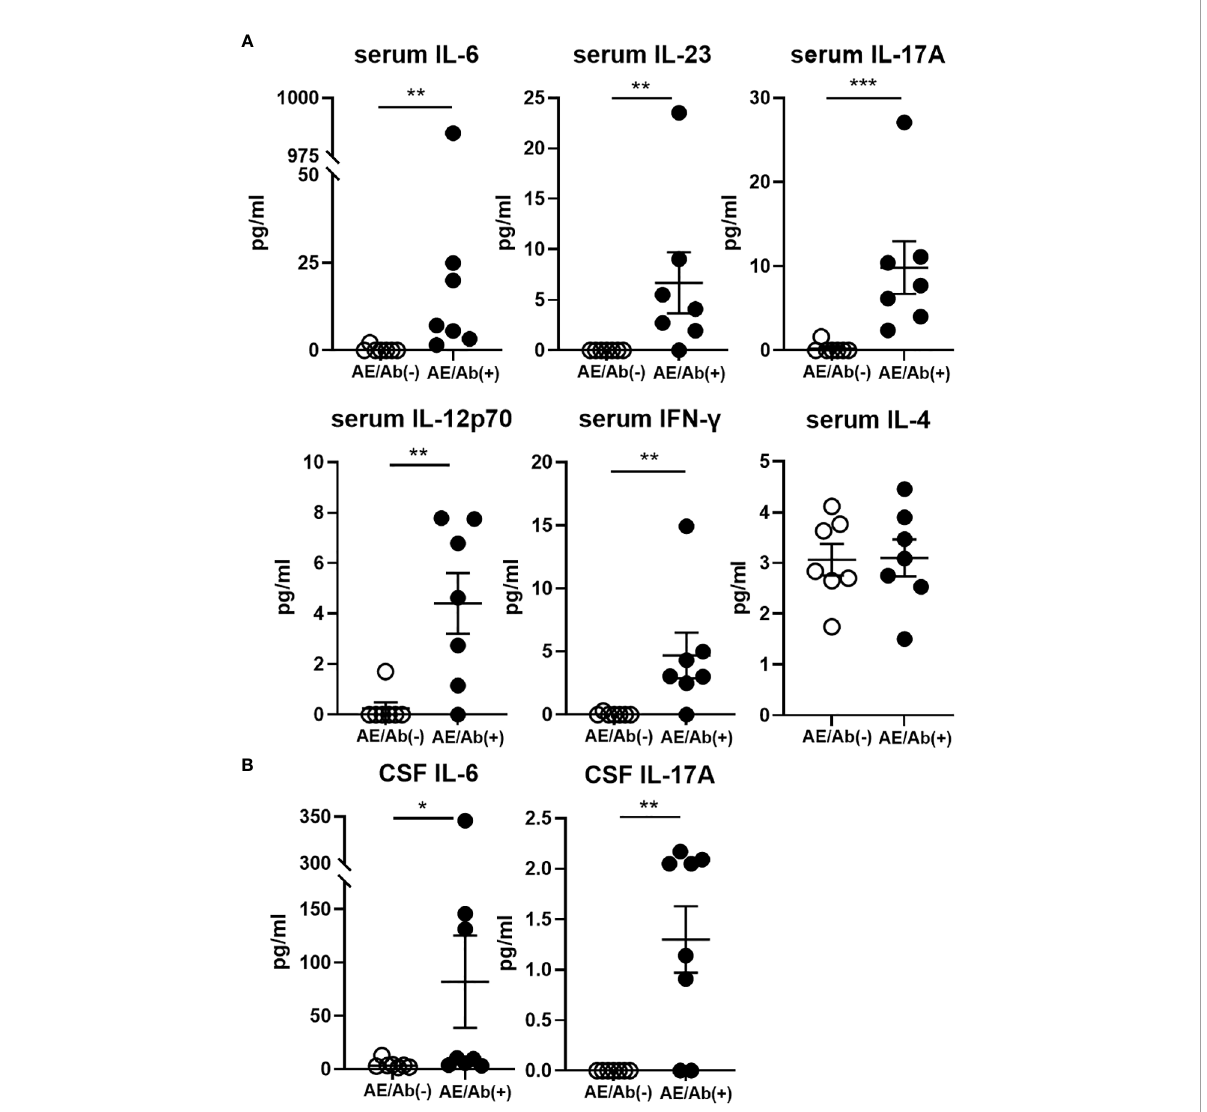
FIGURE 4 Serum and CSF levels of cytokines (pg/ml) in patients with AE/Ab(-) and AE/Ab(+). (A) Serum levels of cytokines (pg/ml) in patients with AE/Ab(-) (n=8) and AE/Ab(+) (n=7). (B) CSF levels of cytokines (pg/ml) in patients with AE/Ab(-) (n=8) and AE/Ab(+) (n=8). Values are expressed as the mean ± SEM. * p < 0.05, **p < 0.01, and *** p <0.001; two-sided unpaired t -test or Mann-Whitney U test, as appropriate. AE/Ab(-), antibody- negative suspected autoimmune epilepsy; AE/Ab(+), antibody-positive autoimmune